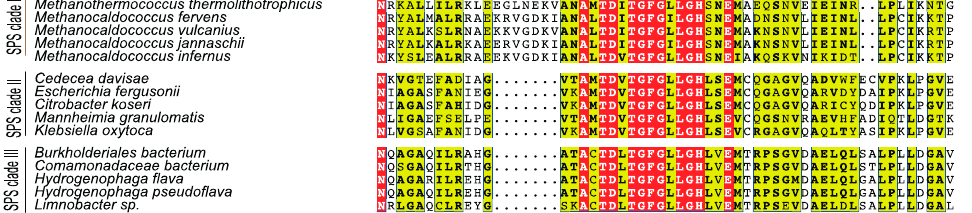
Figure 3. Phylogenetic analysis of selenophosphate synthetase (SPS). ( a ) Reconstructed protein phylogeny of the reference set of SPS proteins. The red point denotes potential horizontal gene transfer events in SPS clades I and II. ( b ) Alignment of SPS domains of the three SPS clades.